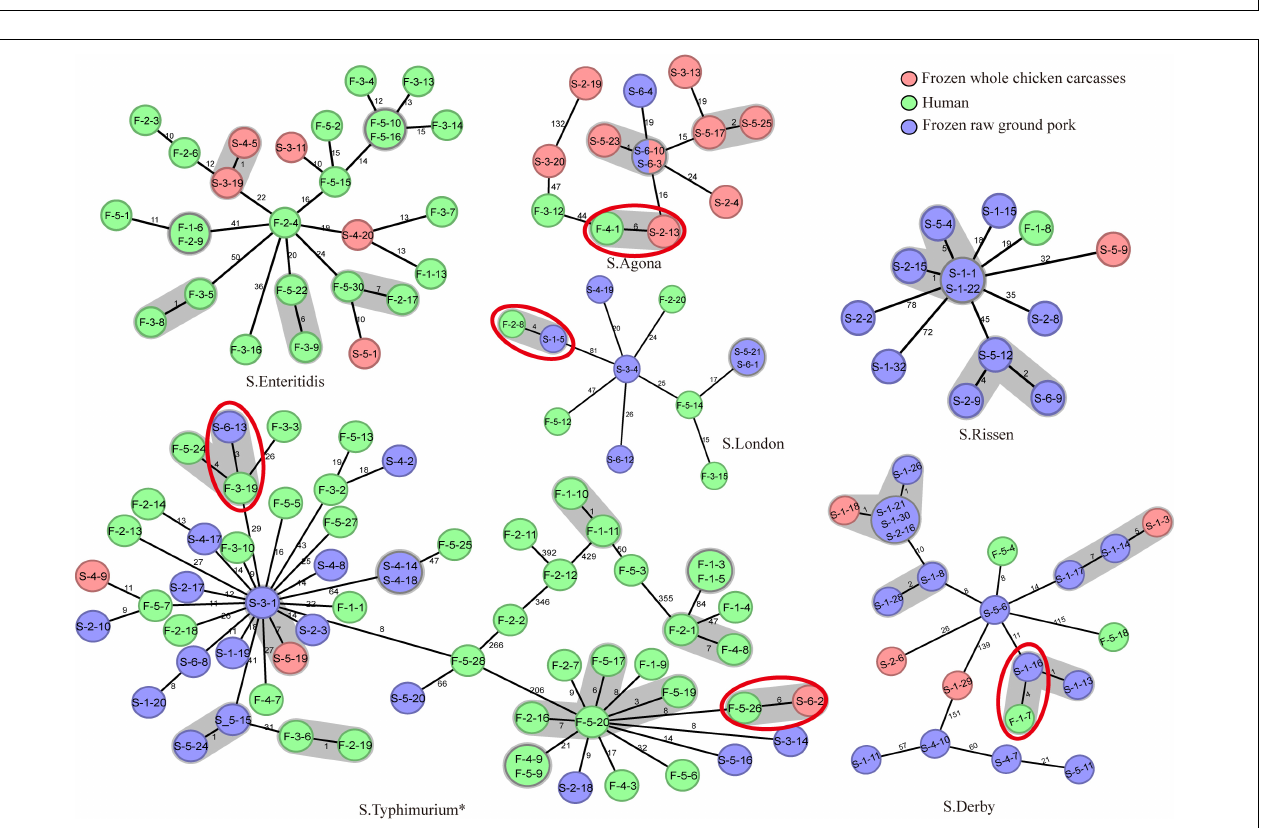
FIGURE 3 | cgMLST-based Minimum Spanning Tree of the six serotypes ( S . Enteritidis, S . Typhimurium, S . London, S . Derby, S . Rissen, and S . Agona) that included both diarrhea patients and poultry meat pathway isolates. The red-dotted circles indicate the cluster covering samples from diarrhea patients and frozen whole chicken carcasses or raw ground pork. The strain name is represented in the circle. The “ ∗ ” means S . Typhimurium and its monophasic variant.